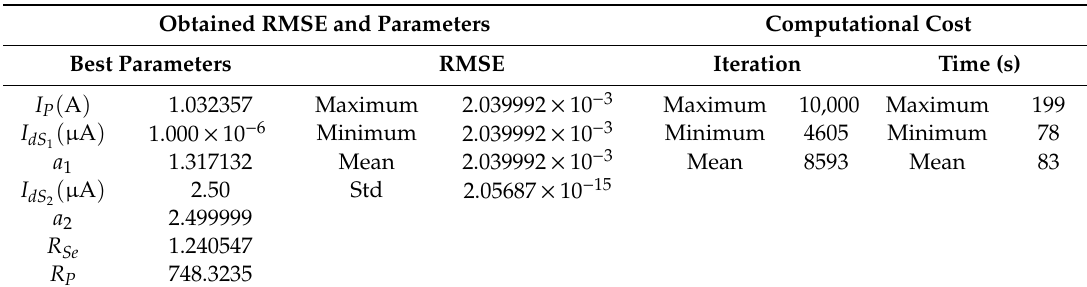
Table 10. Results for the double-diode module.